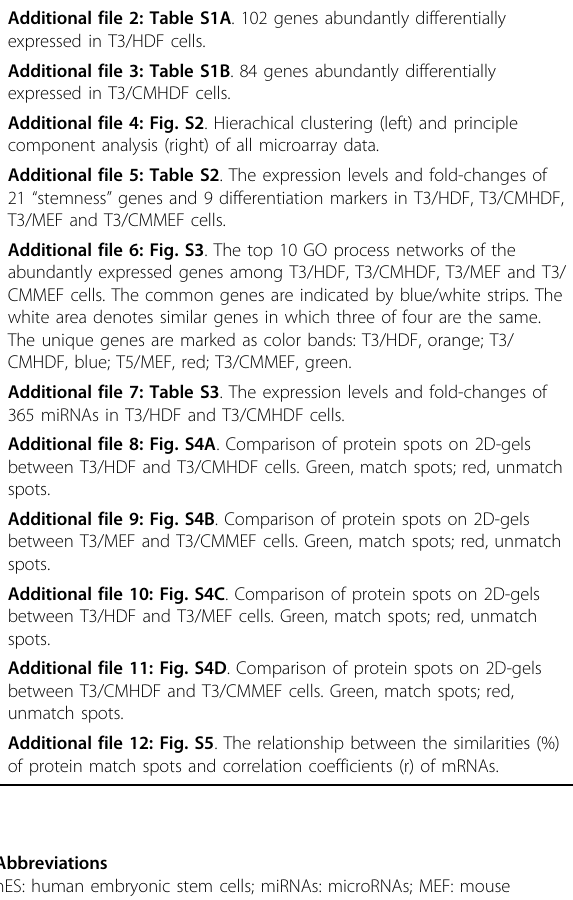
Abbreviations hES: human embryonic stem cells; miRNAs: microRNAs; MEF: mouse embryonic fibroblasts; T3/MEF: hES-T3 cells grown on MEF feeder; T3/ CMMEF: hES-T3 cells grown on feeder-free Matrigel in MEF-conditioned medium; T3HDF: hES-T3 differentiated fibroblast-like cells; T3/HDF: hES-T3 cells grown on T3HDF feeder; T3/CMHDF: hES-T3 cells grown on feeder-free Matrigel in T3HDF-conditioned